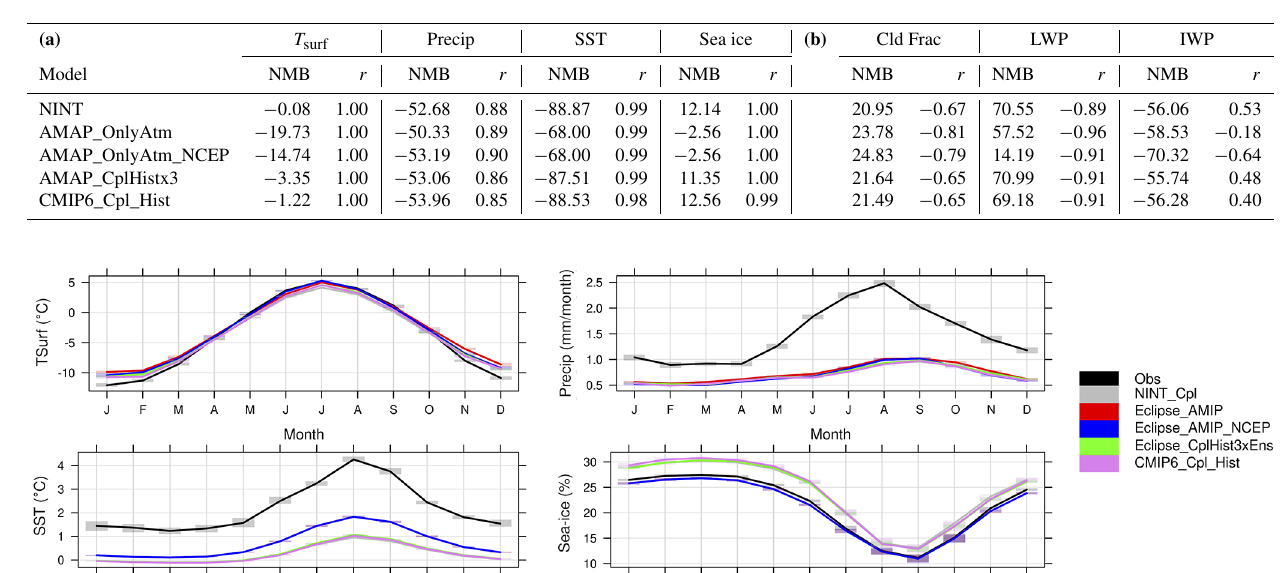
Table 3. (a) Annual normalized mean biases (NMB: %) and correlation coefficients ( r ) for the recent past simulations in the GISS-E2.1 model ensemble in 1995–2014 for surface air temperature ( T surf ) and sea surface temperature (SST) in units of degree Celsius ( ◦ C), precipitation (Precip), and sea-ice fraction (Sea ice). (b) Annual mean normalized mean biases (NMB: %) and correlation coefficients ( r ) for the recent past simulations in the GISS-E2.1 model ensemble in 1995–2014 for total cloud fraction (Cld Frac), liquid water path (LWP), and ice water path (IWP) in units of percent (%).